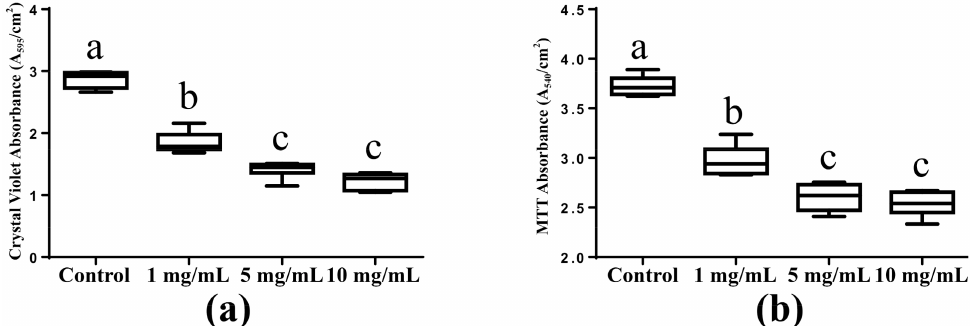
Figure 1. Biomass accumulation and metabolic activity of saliva-derived biofilms on titanium discs. ( a ) Crystal violet assay for the biomass accumulation of saliva-derived biofilms on the titanium discs. ( n = 6); ( b ) MTT assay for the metabolic activity of the biofilms ( n = 6). Significant difference occurs between the bars marked with the different letters (a, b, c) ( p <